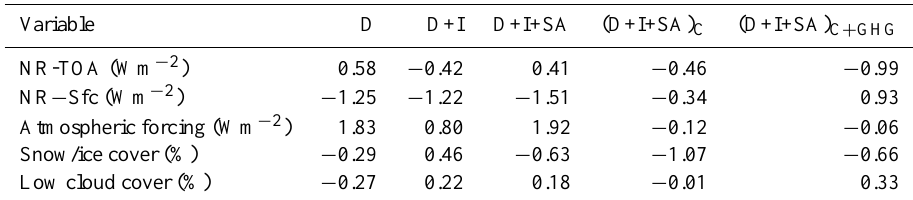
Table 6. Similar to Table 5 but for the Bond emissions. Values for NBC(D+I) are not included since the Beig and Bond emissions only differ in the anthropogenic black carbon included.